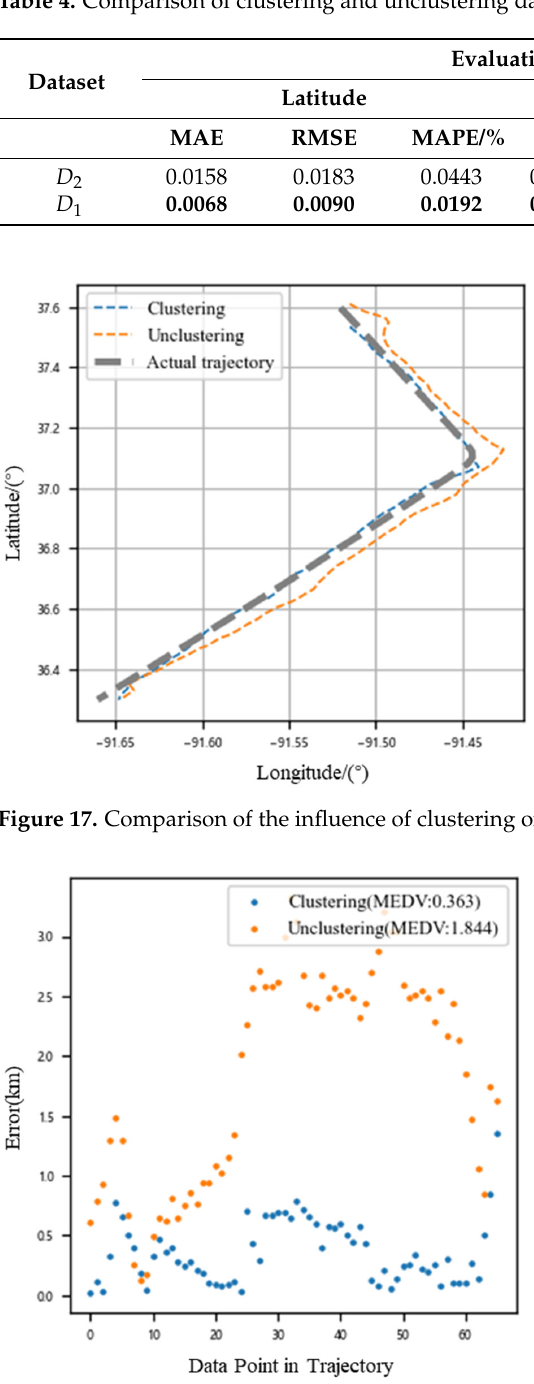
Figure 18. Error scatter plot of two models.